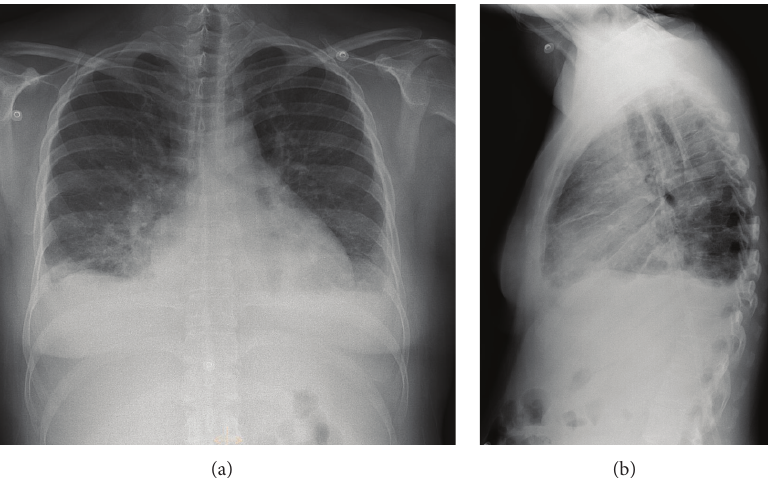
Figure 1: A 42-year-old female with hypertrophic cardiomyopathy and acute pulmonary edema. Findings: chest radiographs (PA (a) and lateral (b)) demonstrate small bilateral pleural effusions, cardiomegaly, and perihilar airspace opacities in keeping with pulmonary edema.